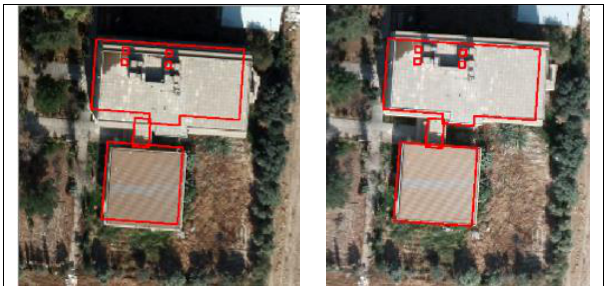
Figure 4. Processed stereo imagery showing the digitised boundary, with the building location digitised using photogrammetric